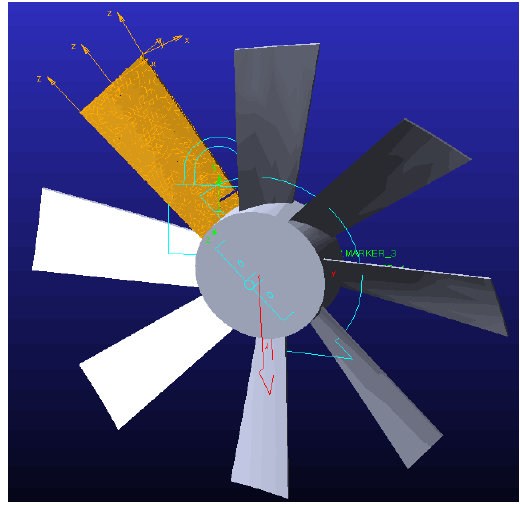
Figure 5. Blade vibration response analysis.